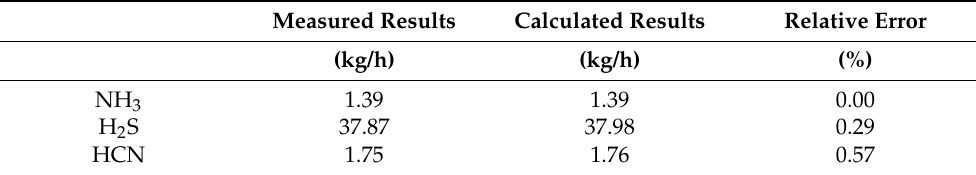
Table 3. Measured and calculated results of the three main impurities in the output coke oven gas. Measured Results Calculated